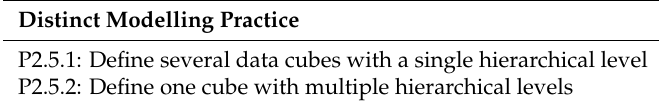
Table 27. Distinct modelling practices of data portals for hierarchical